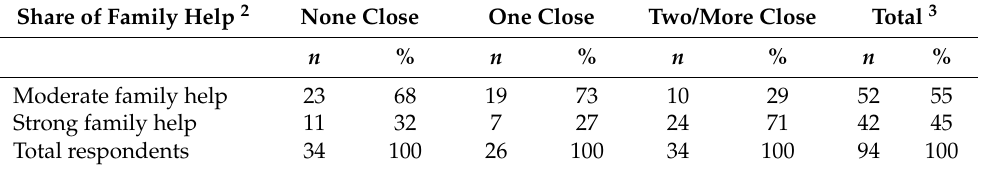
Table 12. Share of family help on total and number of family members living close by who help 1 . Share of Family Help